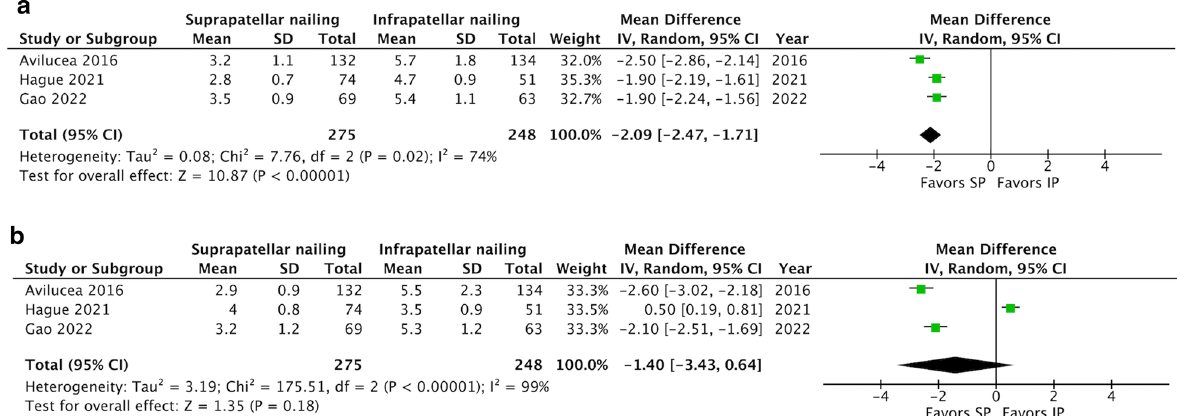
Fig. 5 Forest plots of a coronal angulation and b sagittal angulation. Compared to SP, IP had greater coronal angulation (MD: to 1.71; P < 0.001; I 2 −